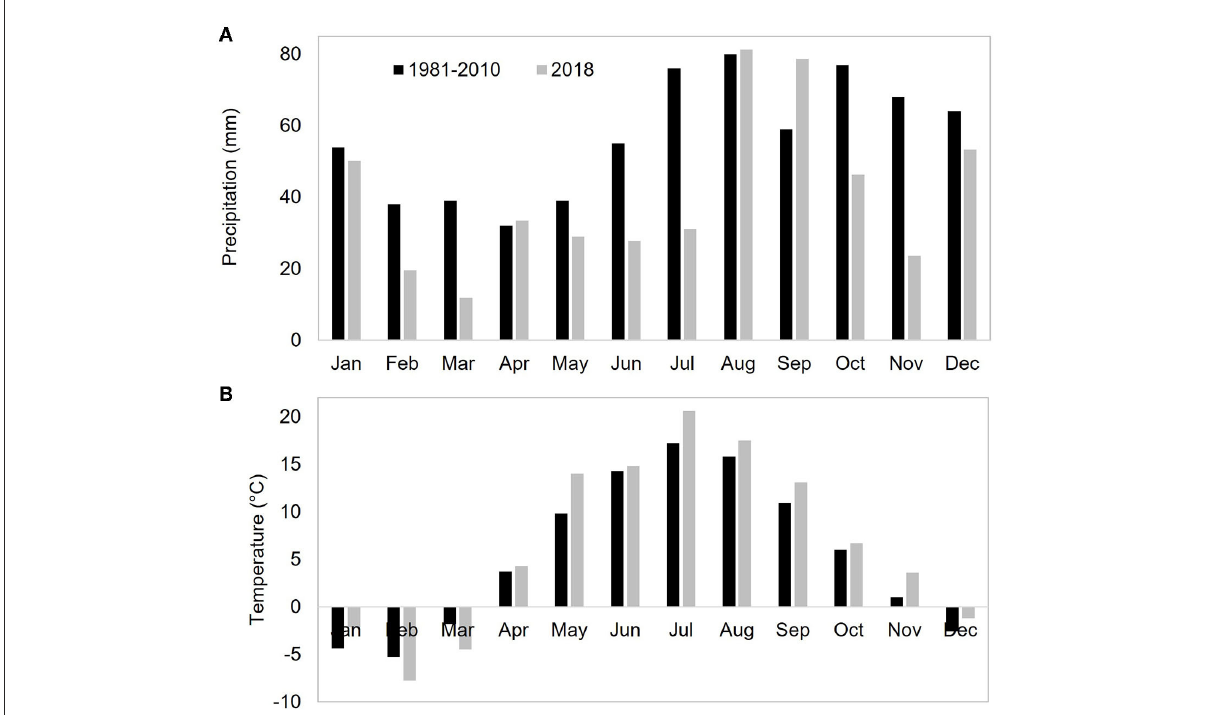
Six soil cores were taken from each of the 15 sampled